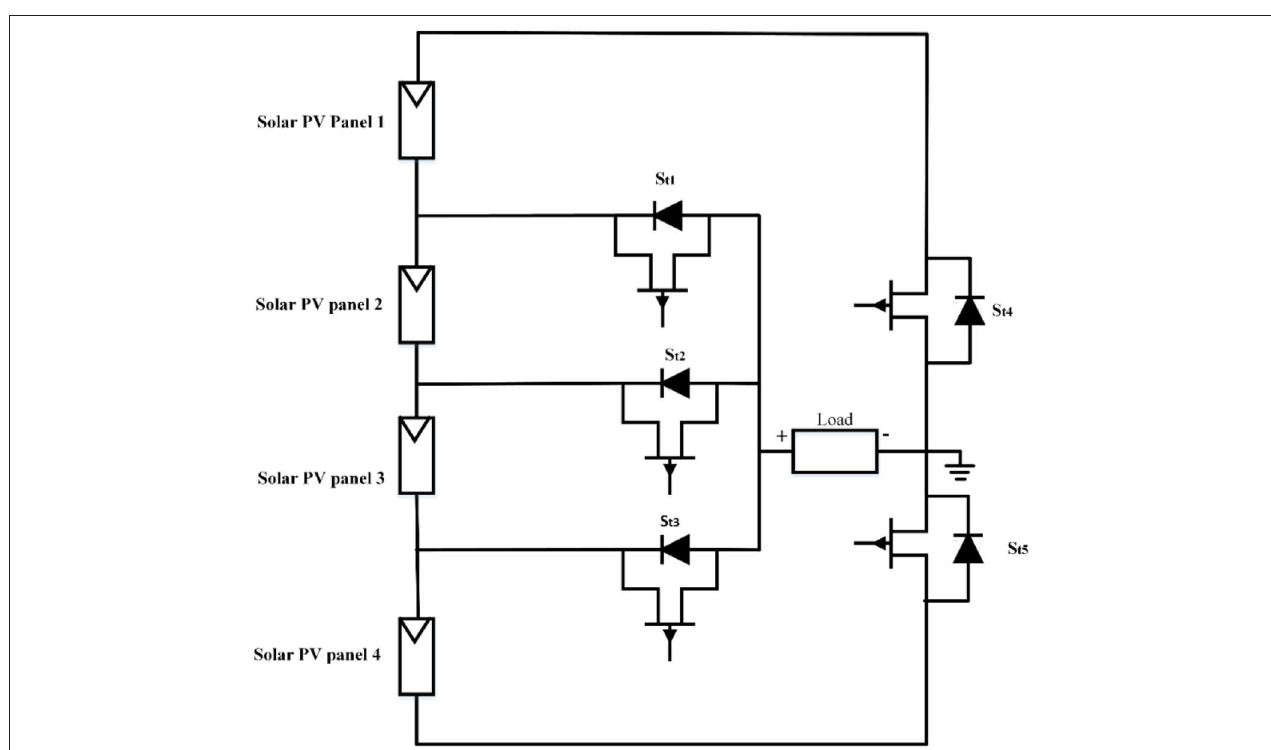
FIGURE 2 | Photovoltaic (PV)-fed seven level inverter with five